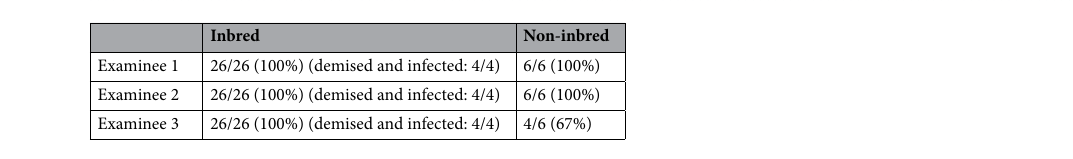
Table 1. Results of blind identification